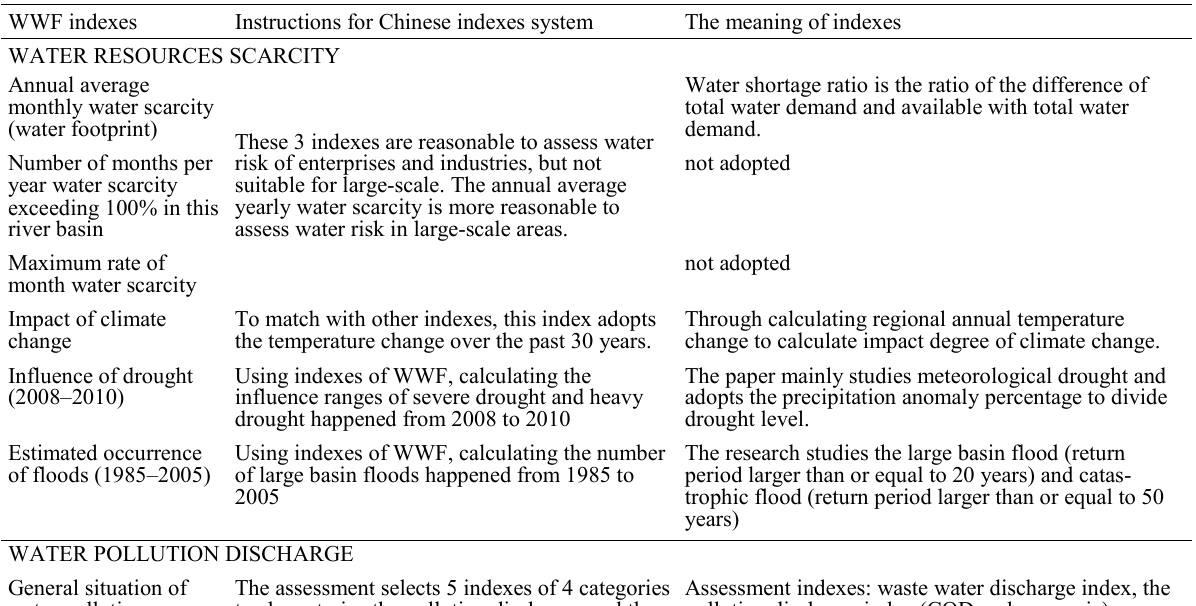
Table 1 Physical risk assessment indexes.